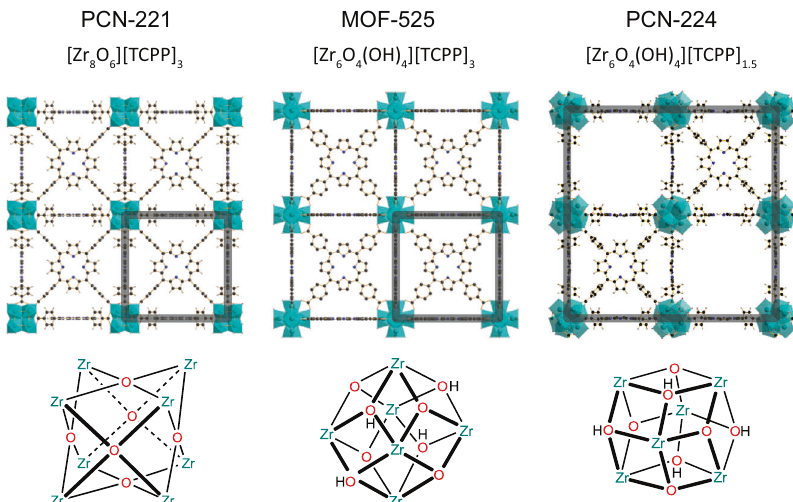
Fig. 1 Published crystal structures of the cubic porphyrinic MOFs. PCN-221, MOF-525, and PCN-224 built of tetrakis(4-carboxyphenyl)porphyrin (TCPP) linkers and Zr-cluster (teal) with unit cells highlighted, viewed along the c -axis, and their corresponding Zr 8 O 6 , straight Zr 6 O 4 (OH) 4 , and tilted Zr 6 O 4 (OH) 4 cluster, respectively 17,21,22